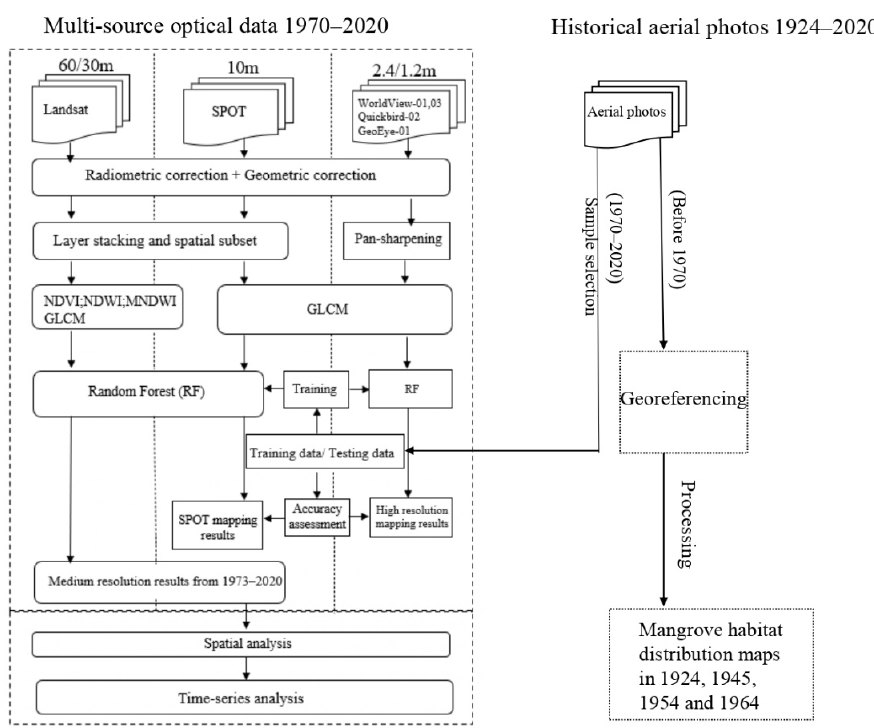
Figure 3. The methodology framework of this study. Multi-source optical data from 1970 to 2020 and historical aerial photos from 1924 to 2020 were separately processed for mapping. Spatial analysis and time-series analysis were conducted based on the mapping results.